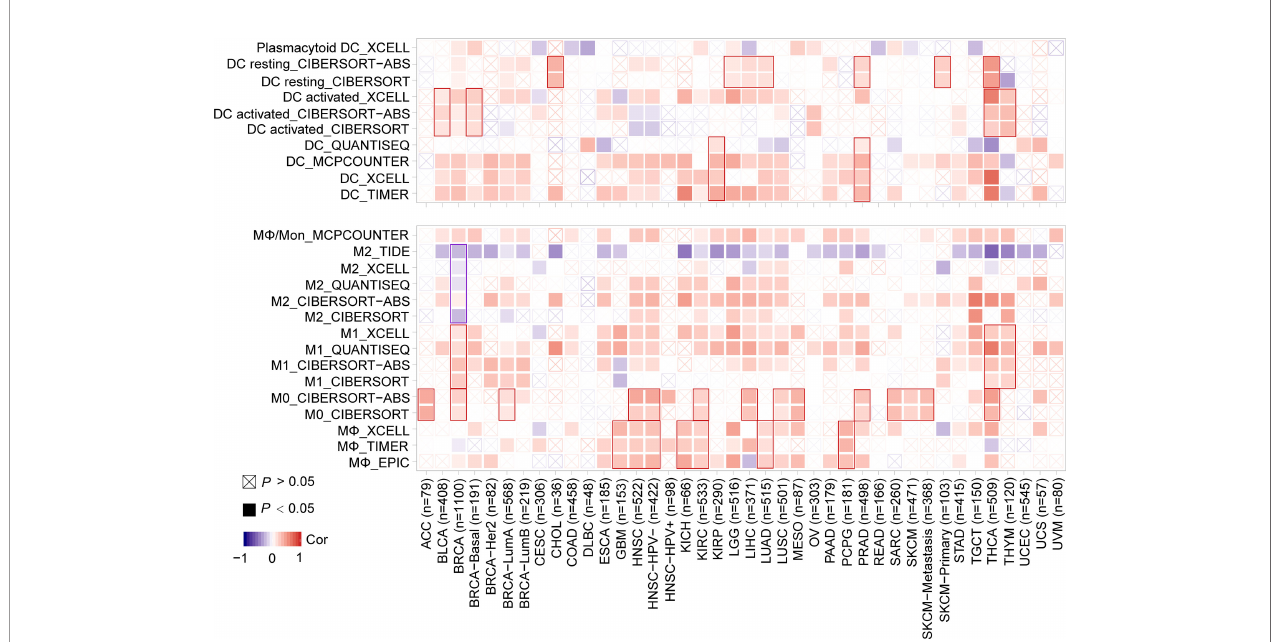
FIGURE 7 | Correlation between MMP7 expression and the in fi ltration level of dendritic cell/macrophage (TIMER2). The fi gure presents the heatmaps of purity-adjusted Spearman ’ s correlation analysis between MMP7 gene expression and the in fi ltration levels of dendritic cell/macrophage in diverse cancer types using EPIC, MCPCOUNTER, XECLL, TIDE, CIBERSORT, CIBERSORT-ABS, and QUANTISEQ